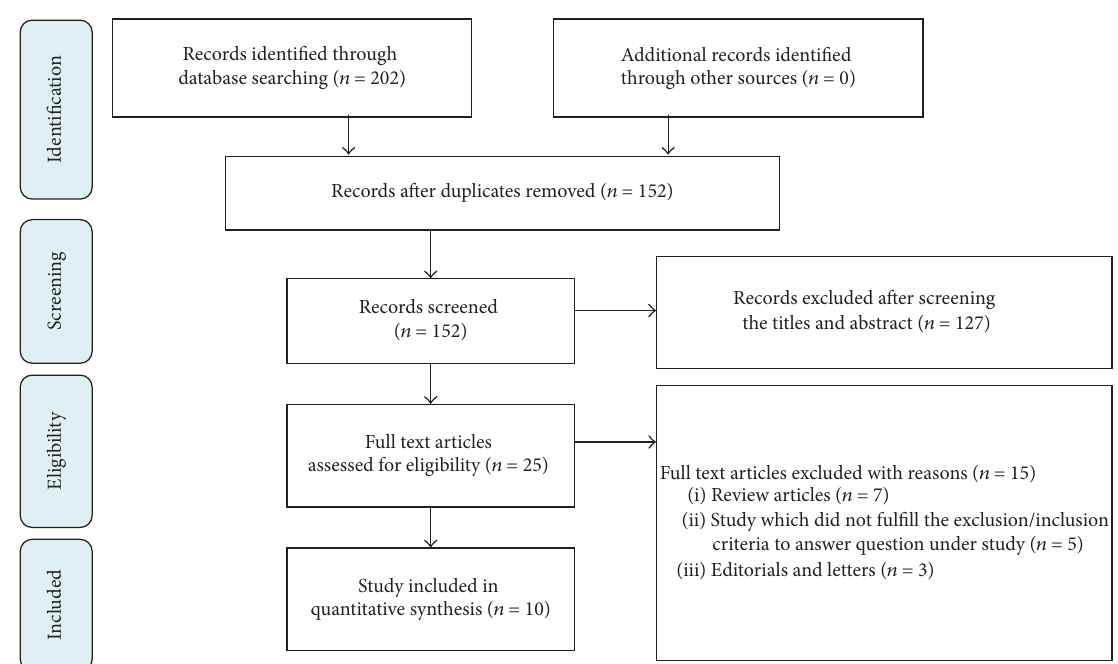
Figure 1: Flowchart for trial identification and selection process using the PRISMA statement for systematic review.